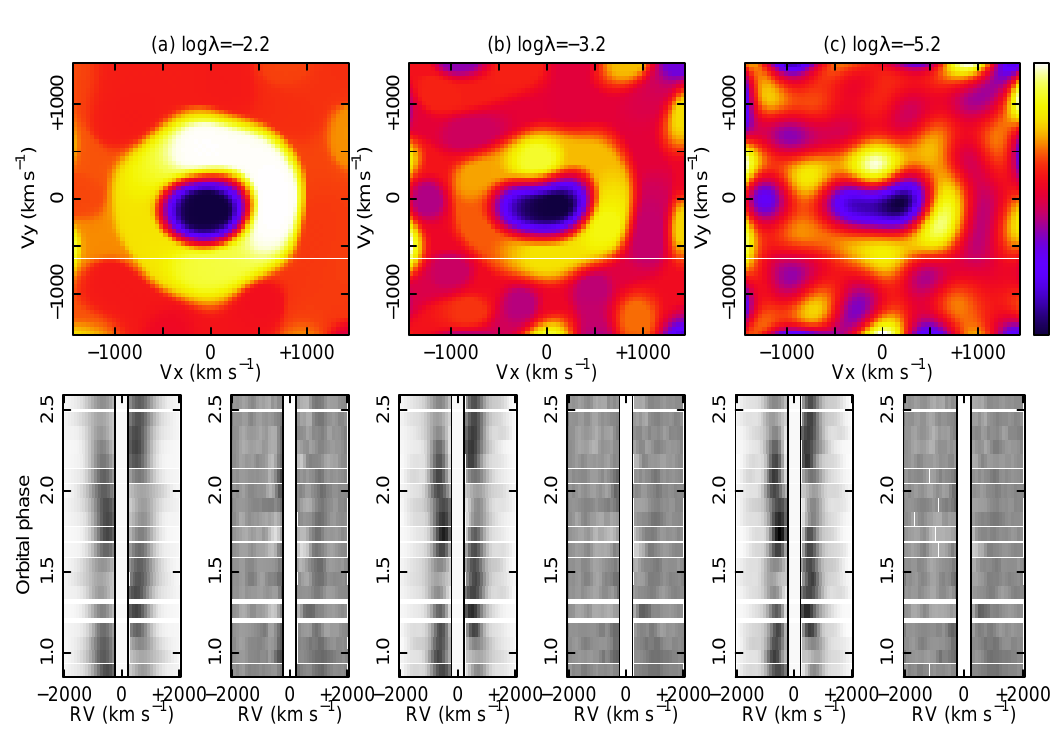
Figure 2: Results of DTTVM for the data of WZ Sge. Upper panels: the Doppler maps. Lower left and right panels: the model spectra and residuals between the model and observed spectra, respectively. The three sets of the panels were calculated with different λ , which are indicated in the figure.